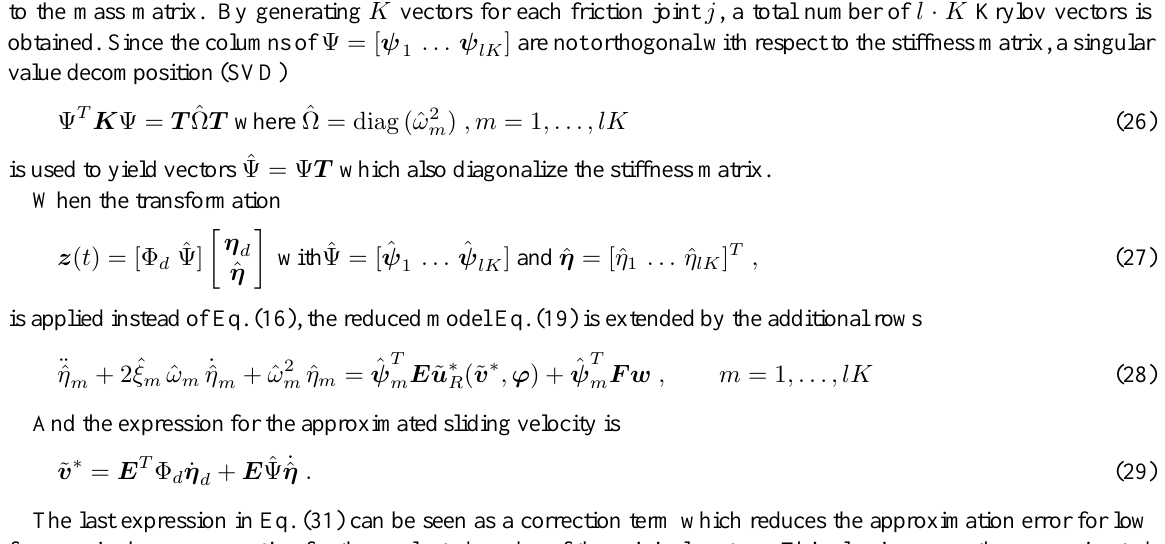
Fig. 9. Eigenvalues w c u